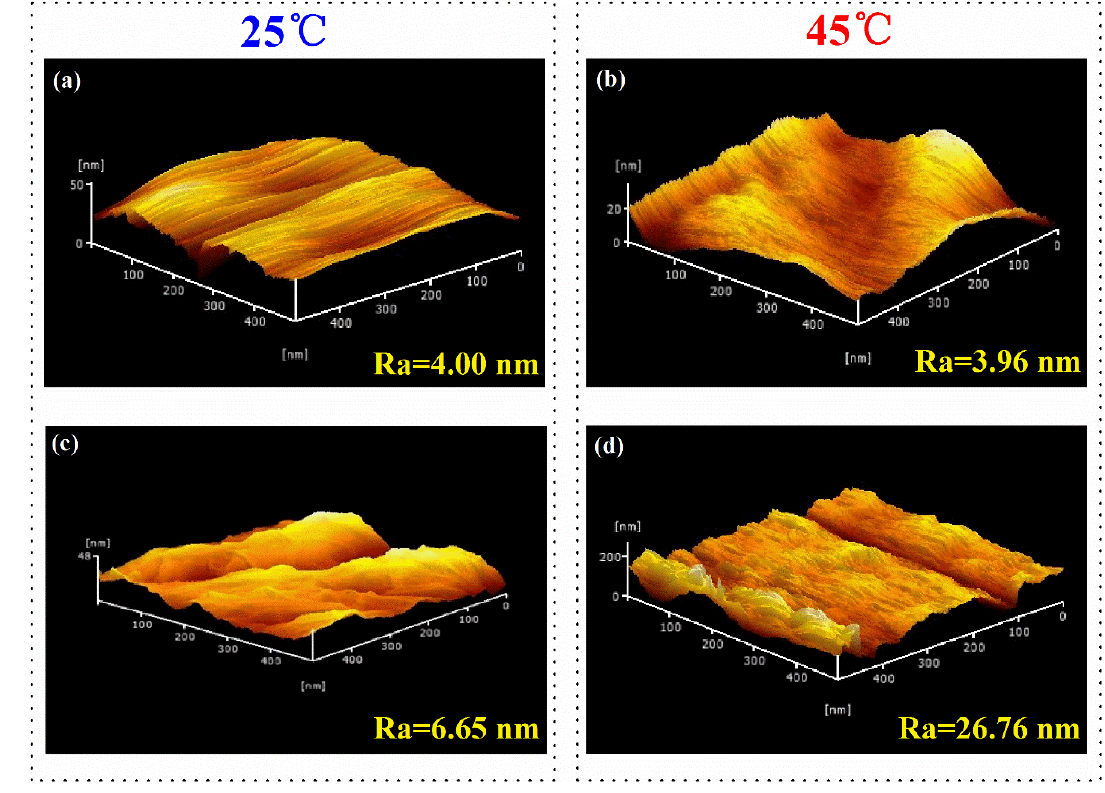
Figure 7. The Atomic Force Microscope spectra of cellulose at 25 °C ( a ) and 45 °C ( b ); and cellulose- g -PNIPAAm at 25 °C ( c ) and 45 °C ( d ).